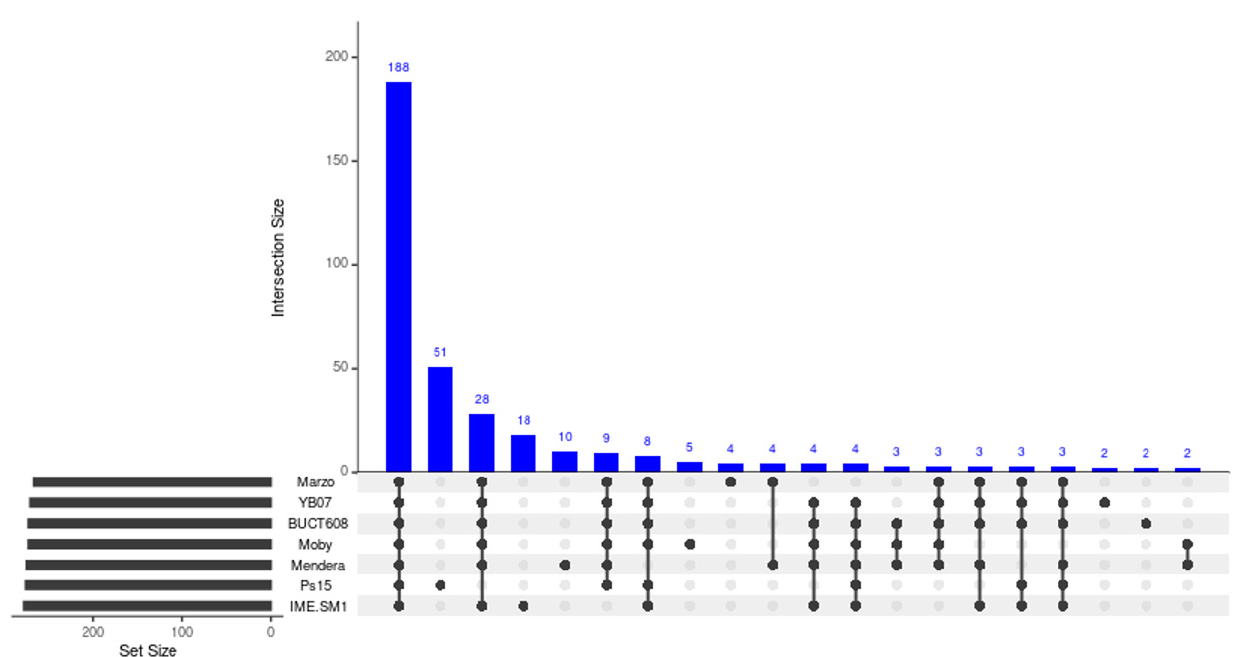
Figure 8. Upset plot depicting the number of shared and unique gene clusters in the Menderavirus genomes. Note that after the core genome (188 gene clusters), the Ps15 singletons (51) and the genes only absent in Ps15 (28) constitute the largest intersections.